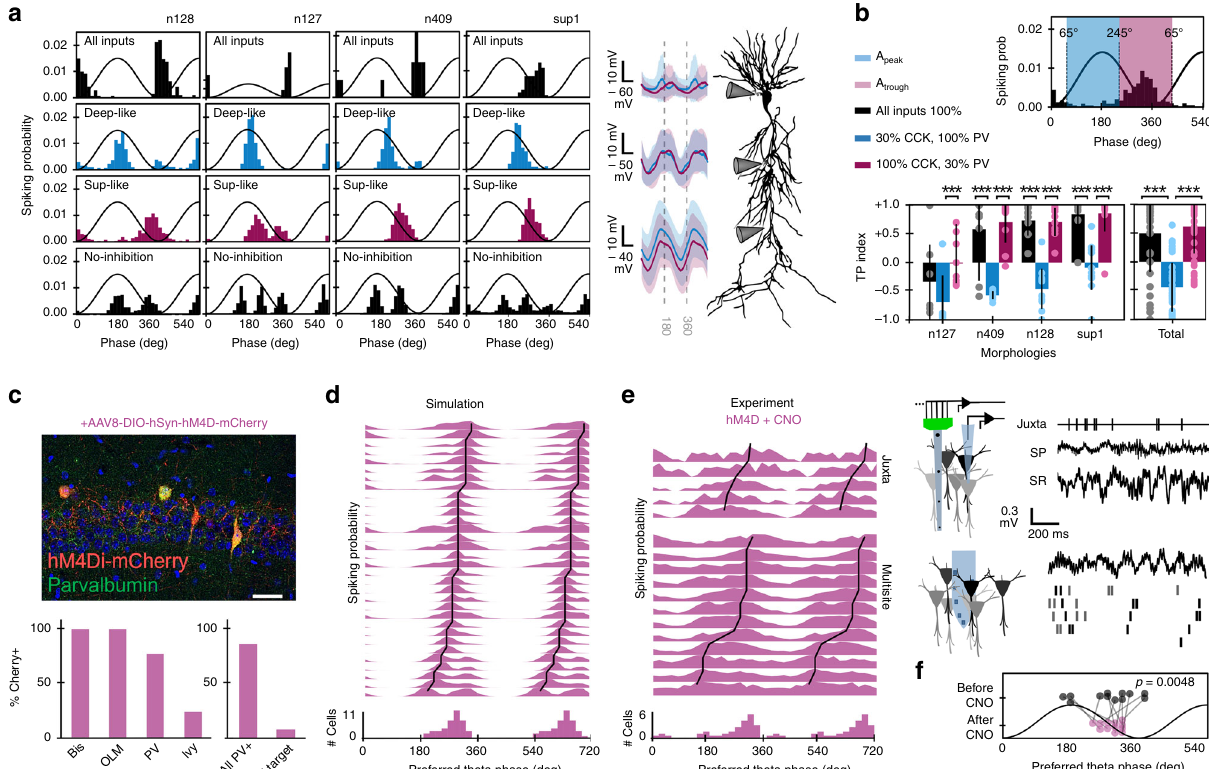
360 (deg)540 720 Preferred theta phase